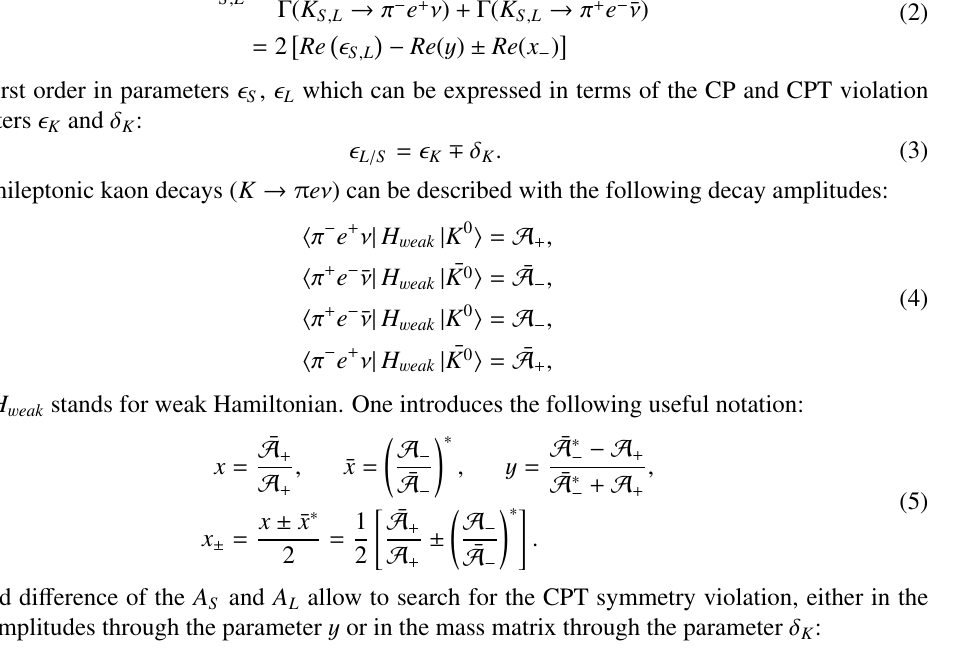
The present fractional experimental uncertainty on V us f + (0) equal to 0.19% can be reduced to 0.14%, using KLOE and KLOE-2 statistics and combining with world average. This result together with more precise measurements of f + (0) and V ud would allow to obtain precision at the level of Table 1. Summary of KLOE results from neutral kaons useful for V us measurement.